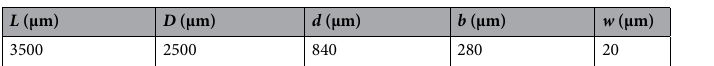
Table 1. Geometrical dimensions of beam-supported diaphragm.